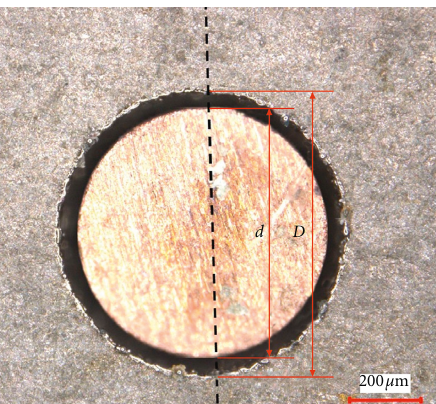
Figure 8: Main discharge working area with a pulse-on time of 1 μ s and a pulse-off time of 20 μ s and peak current of 3A.